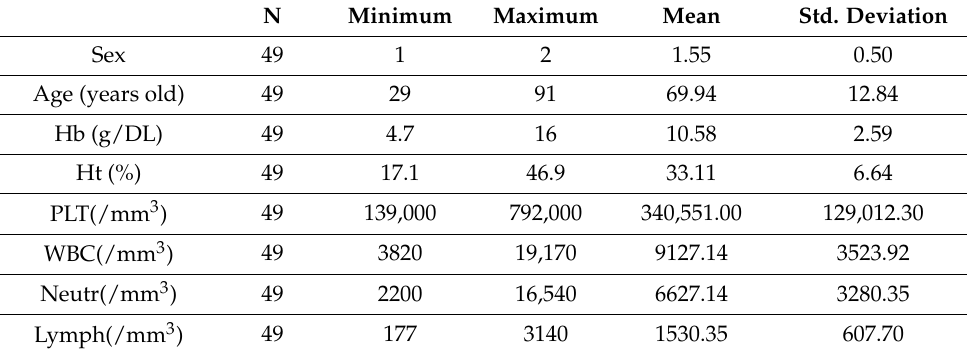
Table 2. Statistics of the parameters considered for colorectal cancer study group.